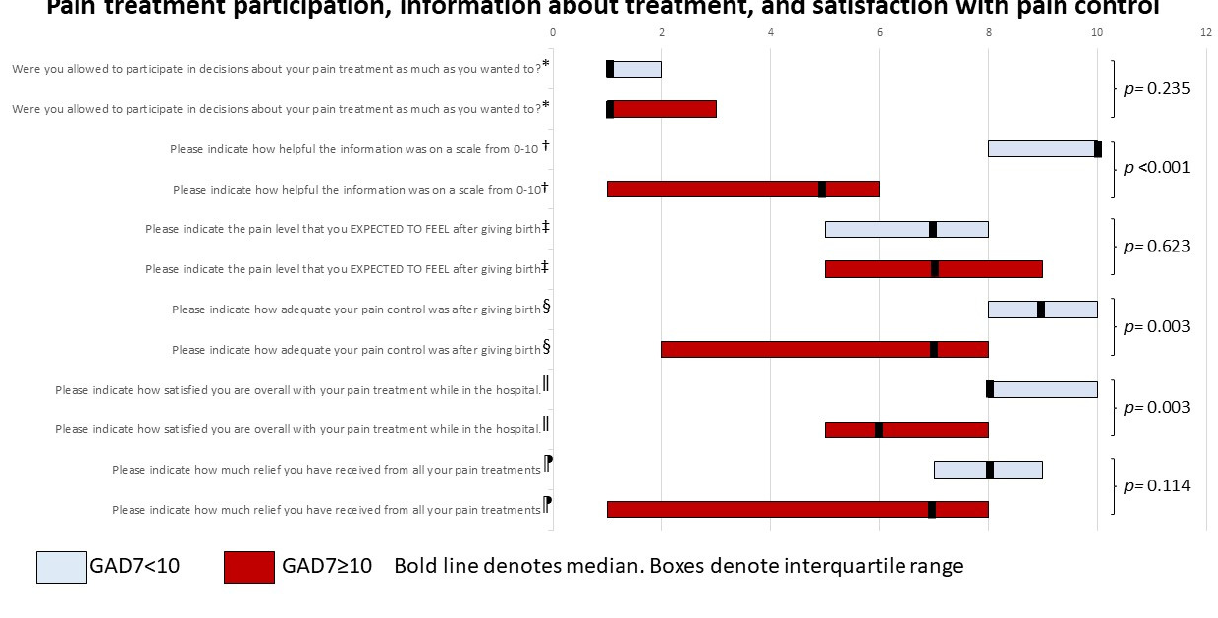
Figure 3. Responses to questions about patient participation in decisions related to pain, information about pain treatment, and satisfaction with pain control. * Responses were 1 = always, 2 = most times, 3 = sometimes, 4 = rarely, 5 = never. † Responses were on scale of 0–10 (0 being not helpful at all, 10 being very helpful). ‡ Responses were on scale of 0–10 (0 = no pain, 10 = extreme pain). § Responses were on scale of 0–10 (0 = completely inadequate, 10 = completely adequate). ‖ Responses were on scale of 0–10 (0 = extremely dissatisfied, 10 = extremely satisfied). ⁋ Responses were on a scale of 0–100% in intervals of 10 (0 = no relief at all, 100% = complete relief). Median and interquartile ranges of responses, Mann–Whitney U-test performed. GAD-7 results < 10 are shown in light blue, GAD-7 results ≥ 10 are shown in red. Bold line denotes the median and boxes denote the interquartile range. When classifying anxiety as no anxiety (GAD-7 score less than 5), mild anxiety (GAD-7 score 5 to 9), moderate anxiety (GAD-7 score 10 to 14), and severe anxiety (GAD-7 score greater than 15), similar results were observed. (Table 4.) Specifically, increasing anxiety severity was inversely associated with the lowest pain score being less than or equal to 3 ( p = 0.002) and directly associated with any severe pain in the second 24 h time period after cesarean ( p = 0.047). Table 4. Associations between pain and anxiety with anxiety categorized as no anxiety (GAD-7 < 5), mild anxiety (GAD-7 = 5–9), moderate anxiety (GAD-7 = 10–14), or severe anxiety (GAD-7 = 15–21).